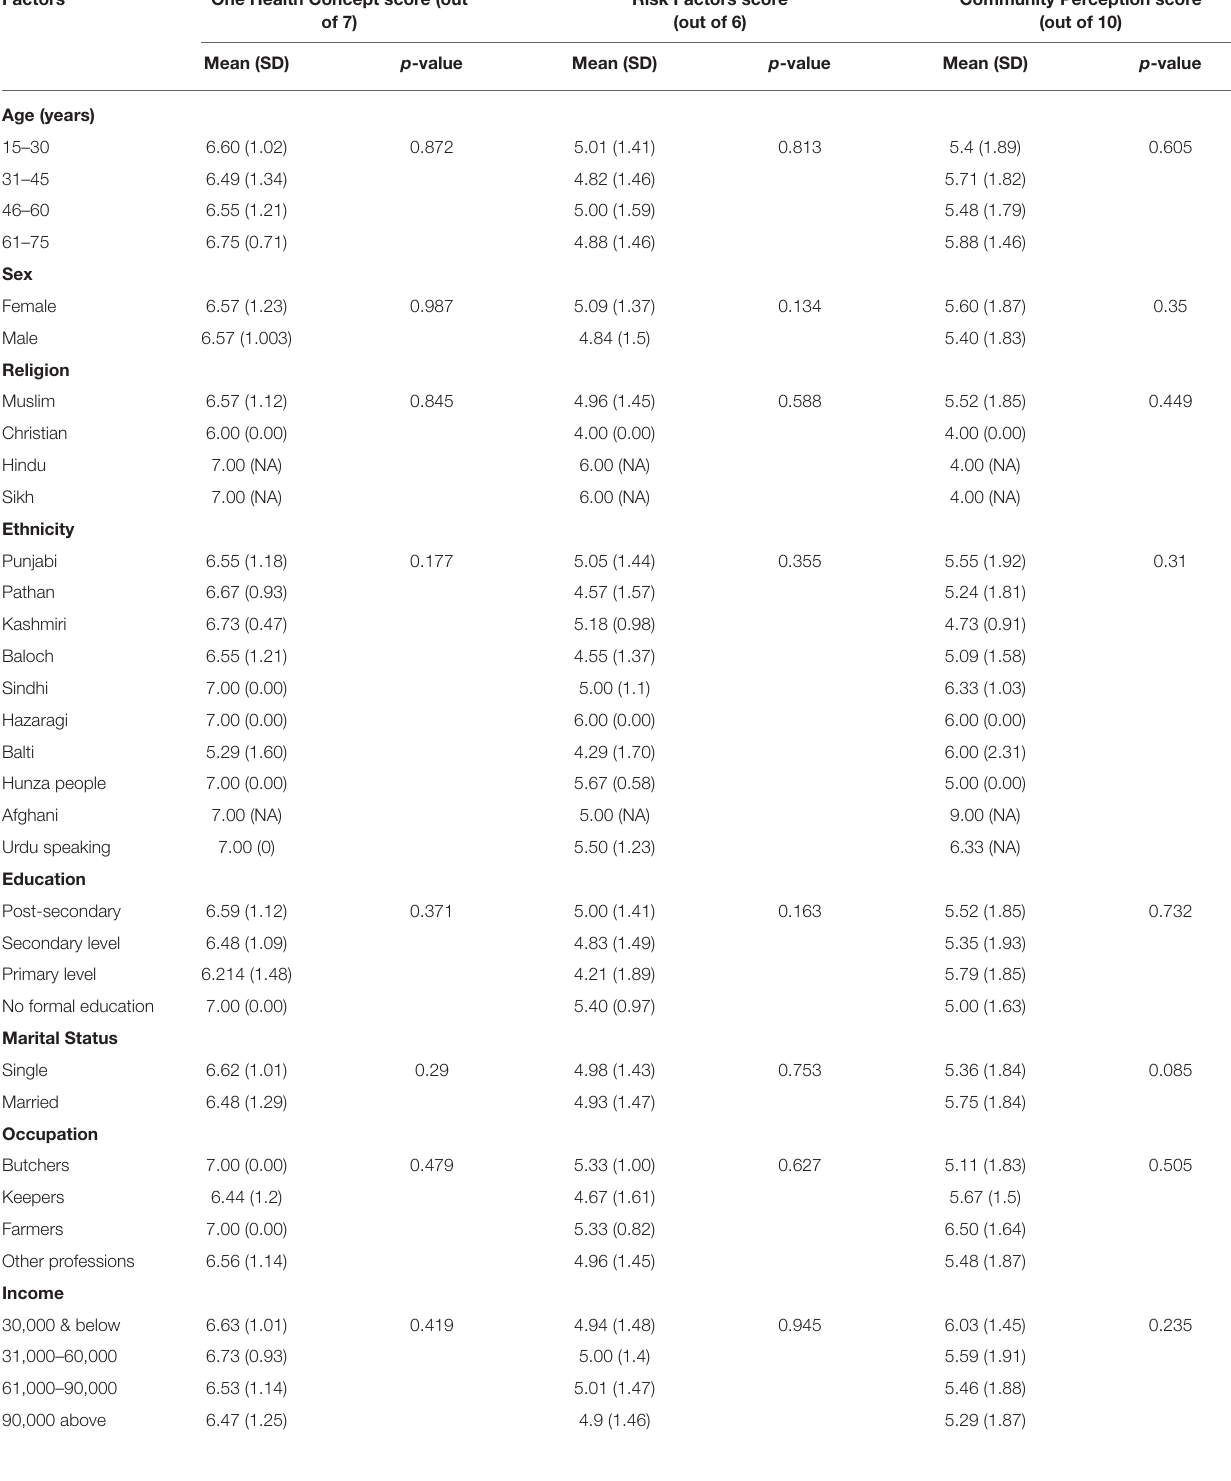
TABLE 10 | Statistical analysis of one health concept, risk factors, and community perceptions. Factors One Health Concept score (out